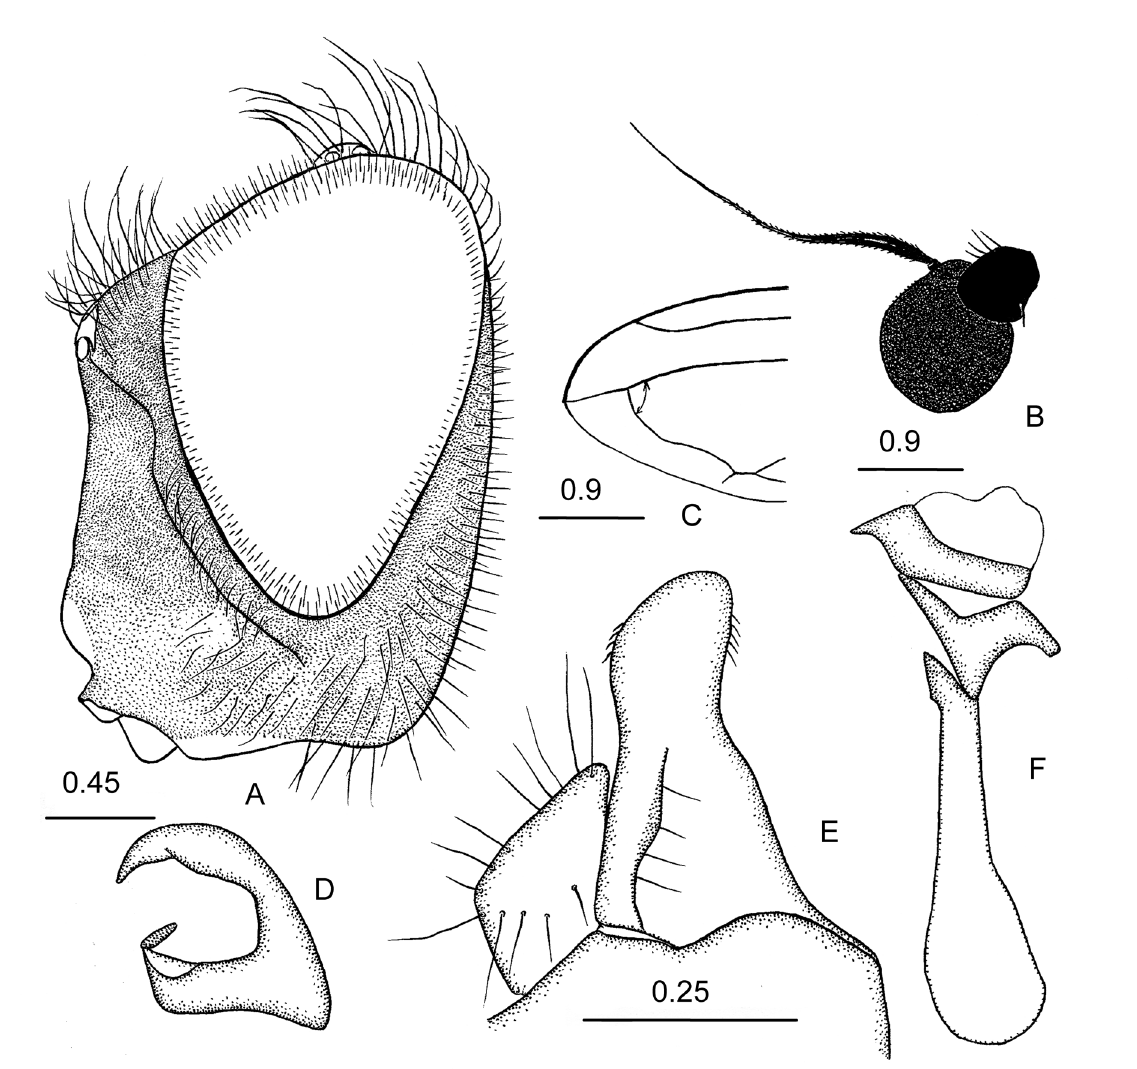
Fig. 57. Cheilosia ( Pollinocheila ) rava sp. nov., holotype, ♂ (IBSJW/NME). A . Head, lateral view. B . Antenna, lateral view of pedicel and basoflagellomere. C . Tip of wing. D . Superior lobe of hypandrium, lateral view. E . Surstylus and gonocercus, lateral view. F . Aedeagus and aedeagal apodeme, lateral